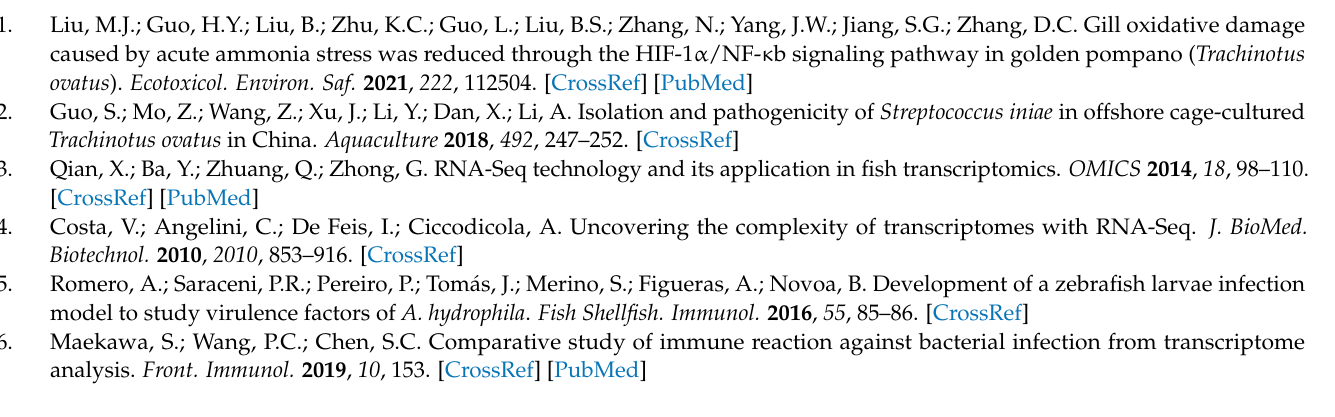
Figure S4: Changes in JAK-STAT signaling pathway at different time points after infection. Red boxes indicate genes with increased expression; Green boxes indicate genes with reduced expression; Purple boxes indicate genes whose expression is uncertain; Table S1: Disembarkation data; Table S2: Data filtering